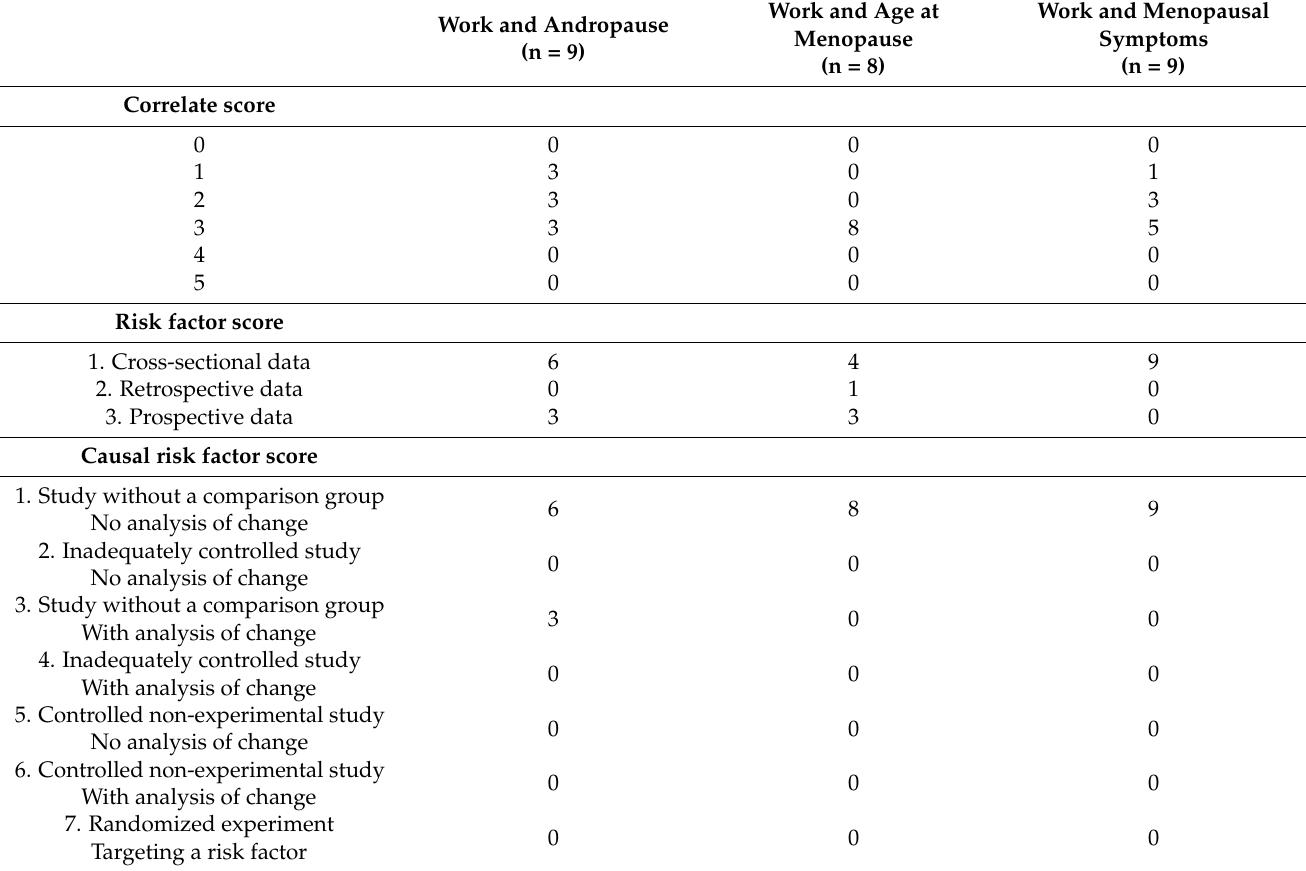
Table 5. Cambridge Quality Checklist scores of the studies included in the systematic review. Work and Work and Age at Work and Andropause Menopause (n = 9)